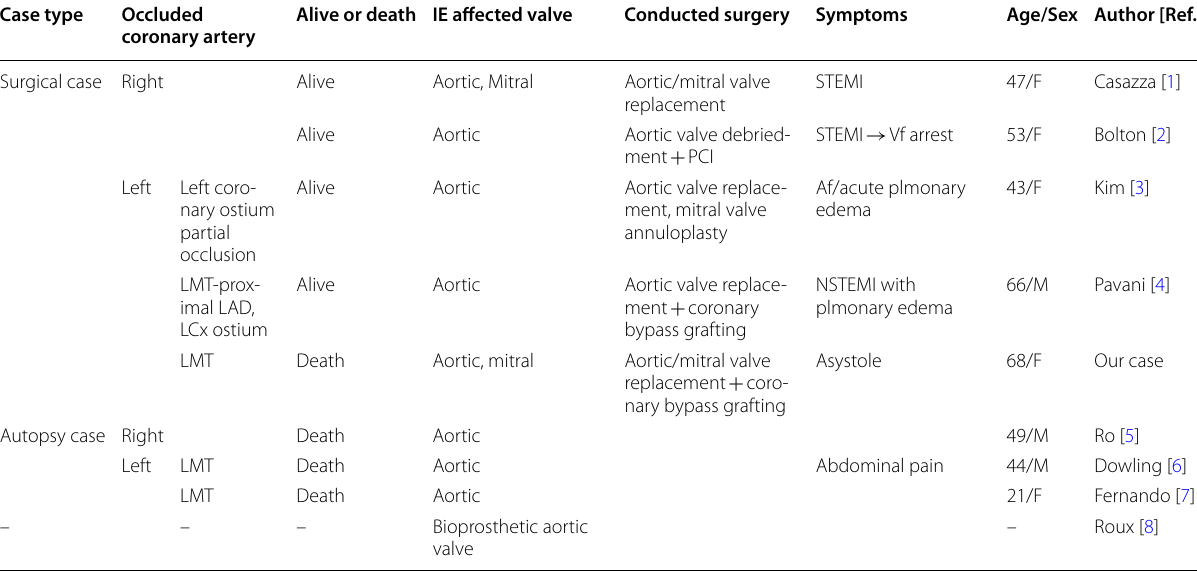
LMT left main coronary trunk, STEMI ST-elevation myocardial infarction, F female, M